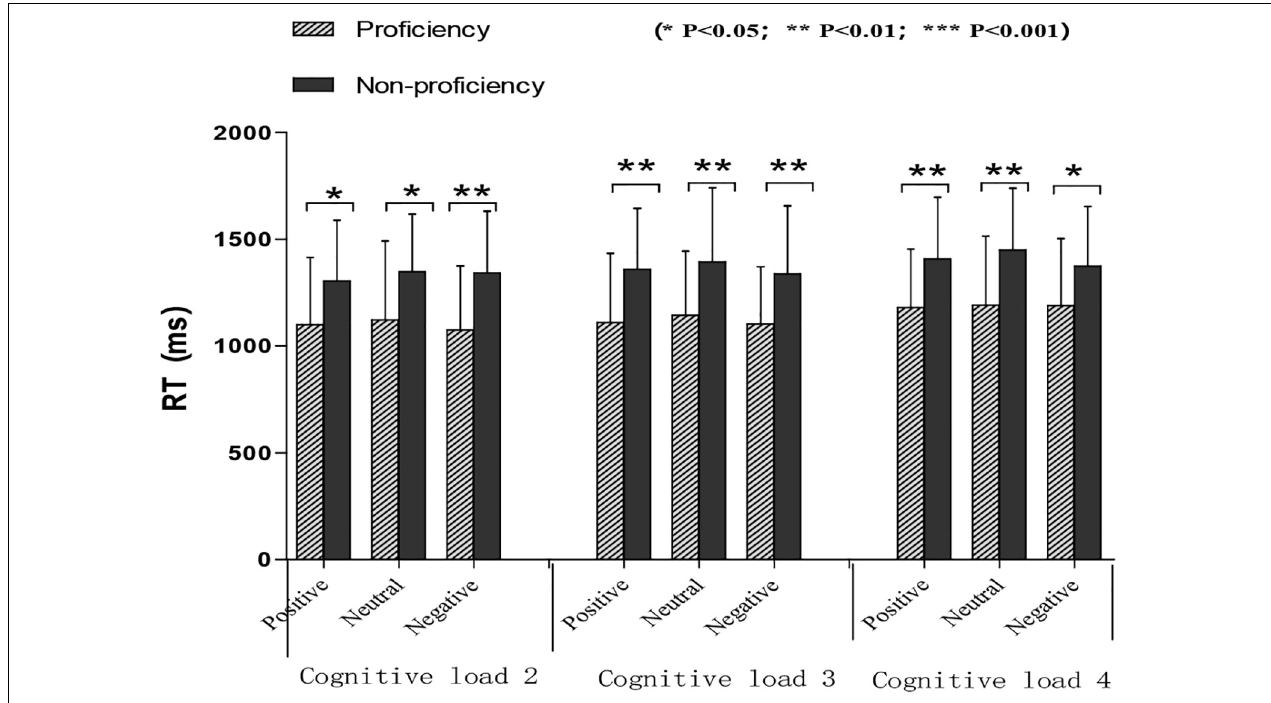
FIGURE 2 | Mean score and standard deviation for reaction time on emotional delay-matching-to-sample task by different language groups by different language groups. The reaction time of proficient bilinguals was shorter than that of non-proficient bilinguals, and the difference was significant in all